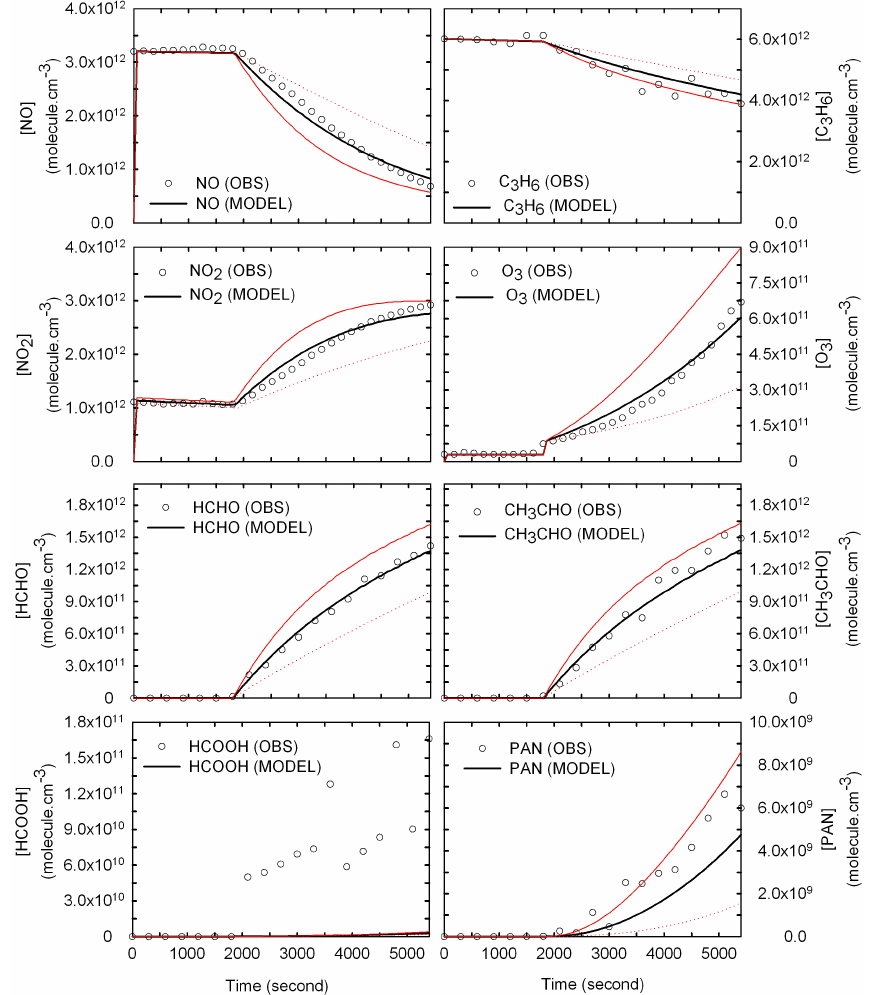
Fig. 8. Comparison of simulated (solid lines) and experimental concentrations (symbols) for NO, NO 2 , ozone, propene, formaldehyde, acetaldehyde, formic acid and peroxyacetyl nitrate (PAN) in a propene-NO x -Air system. Black lines are the results of modeling with an initial concentration of nitrous acid [HONO] 0 =8ppb while continuous red lines are for [HONO] 0 =12ppb and dashed red lines for [HONO] 0